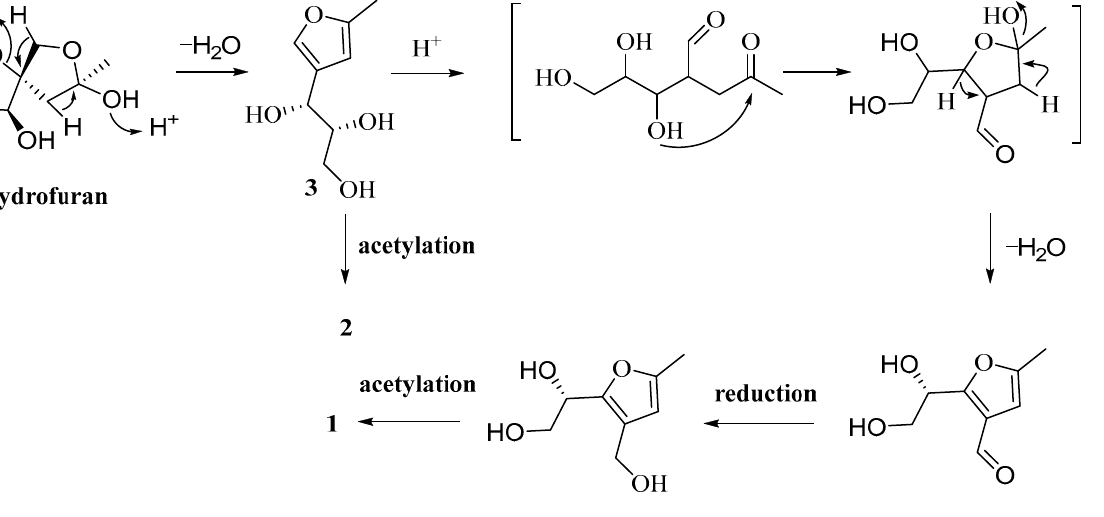
Figure 5. Proposed biosynthetic pathways for compounds 1–3.